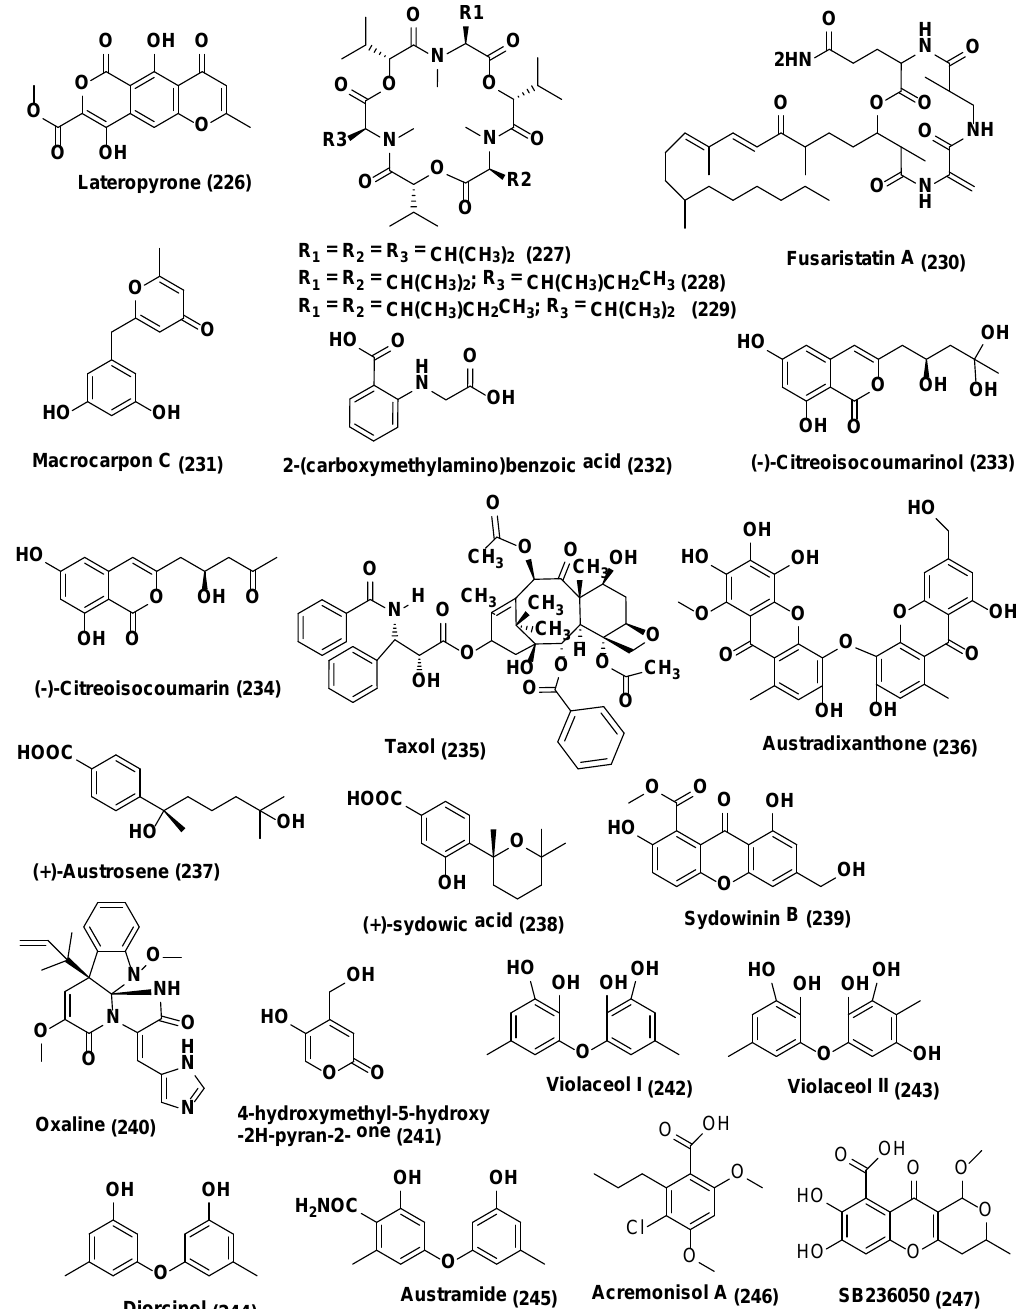
Figure 12. Structures of metabolites obtained from co-culture in endophytic fungi ( 226 – 247 ).